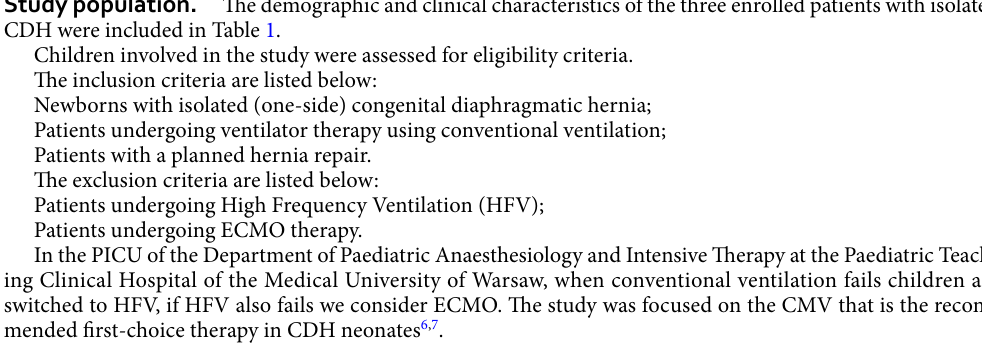
Table 1. Demographic data of patients. *CDH diagnosis—1 week before delivery. GA gestational age, BW body weight. ETT endotracheal tube size, O/e LHR observed to expected lung to head ratio.